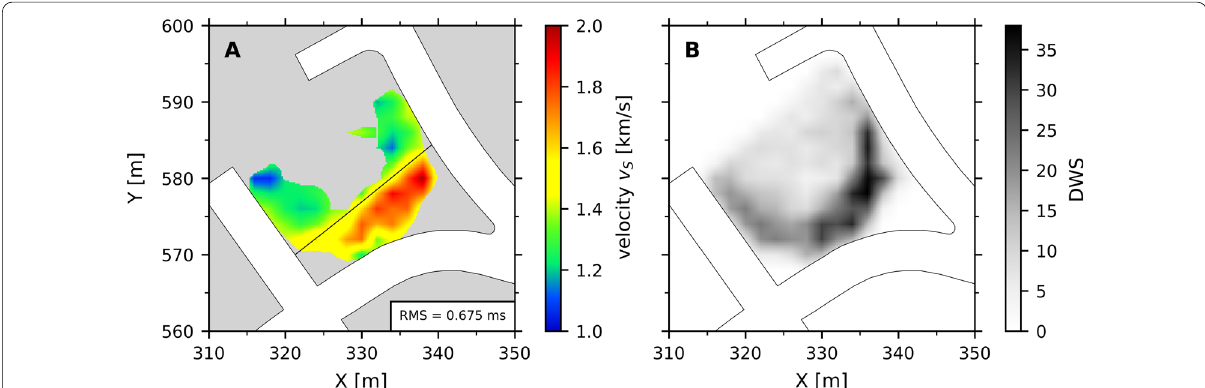
Fig. 7 Tomography of S-wave traveltimes. A velocity model. B DWS. The black line in A indicates the transition between shaly and carbonate-rich sandy facies at height of the inversion plane. The outline of the tunnel is shown as white polygon in all figures